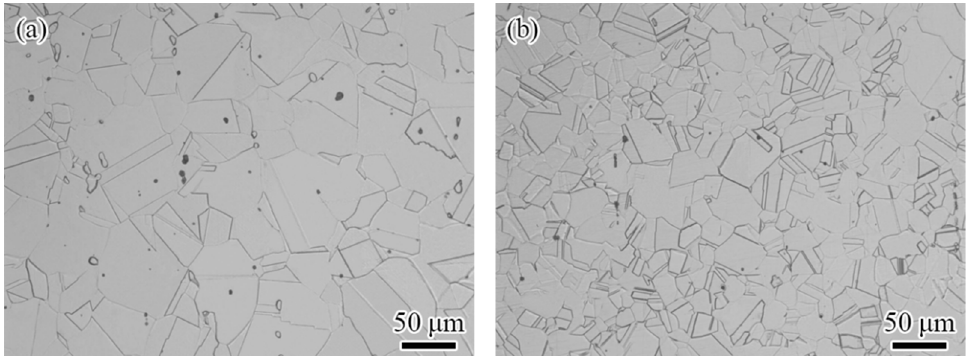
Figure 1. OM images showing the initial microstructures in the Fe-19Cr-16Mn-2Mo-0.49N ( a ) and Fe-18Cr-16Mn-2Mo-0.85N ( b ) steels.